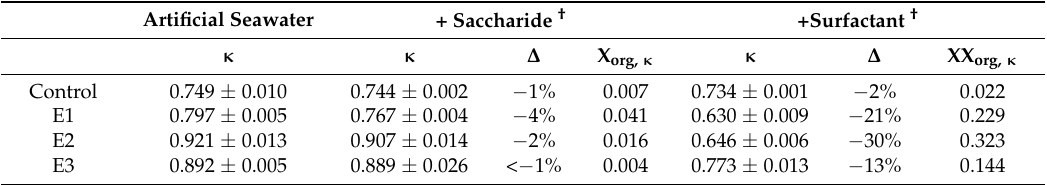
Table 2. Observed κ -values (3-trial average ± σ ), s percent changes in κ ( ∆ ), and corresponding aerosol organic volume fractions (X org, κ for each addition of the MART